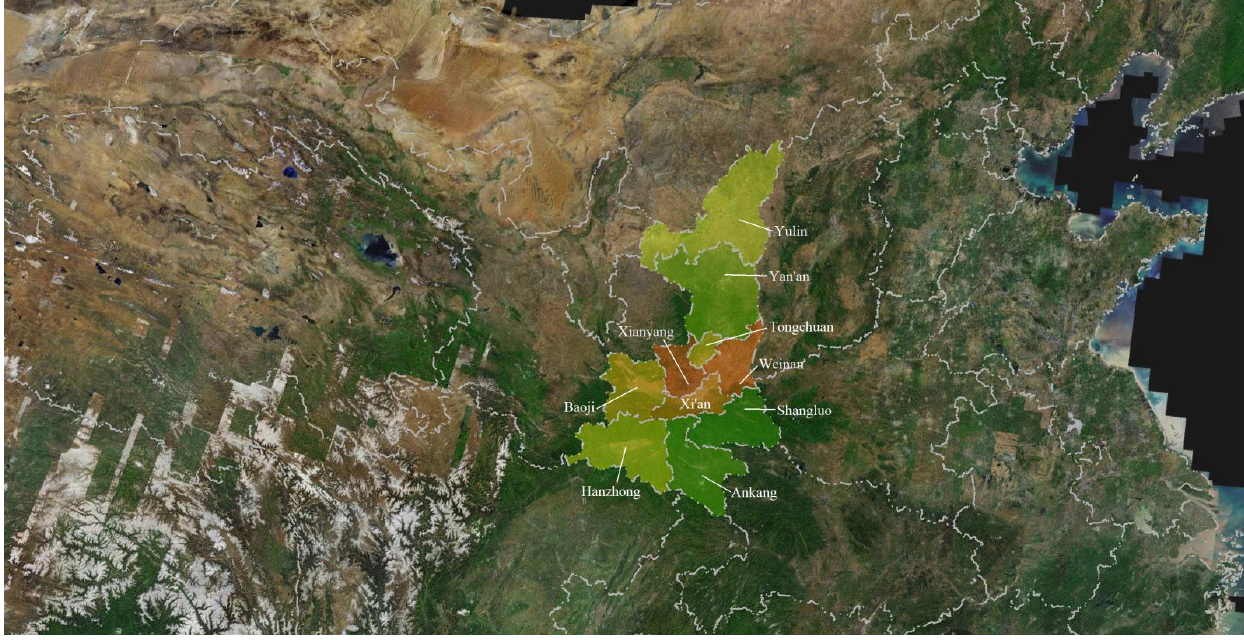
Figure 1. The geographical location and average annual concentration of PM 2.5 of the study area in